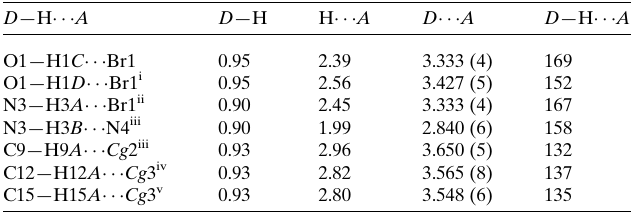
Table 1 Hydrogen-bond geometry (A˚ , (cid:4) ). Cg 2 and Cg 3 are the centroids of the N4/C5–C9 pyridine and C10–C15 phenyl ring, respectively.